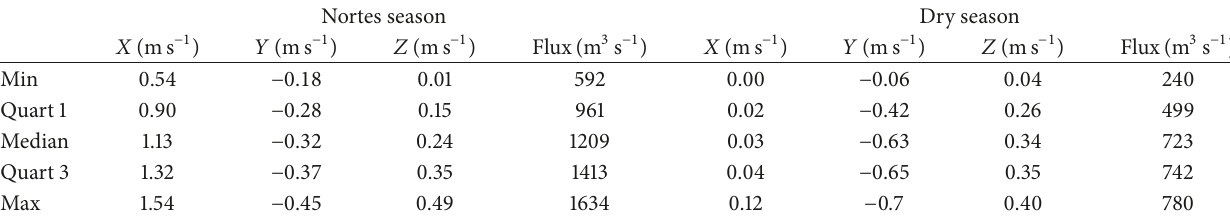
Table 1: Flow velocity and direction from the X’Buya-Ha discharge. “ 𝑋 ” represents flows oriented north-south, “ 𝑌 ” represents flows oriented east-west, and “ 𝑍 ” represents upward